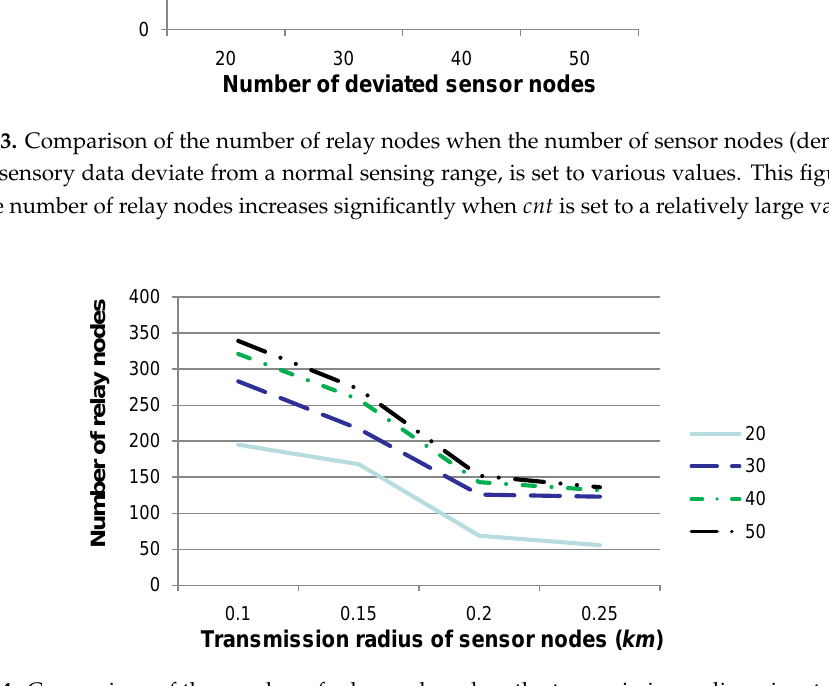
Figure 4. Comparison of the number of relay nodes when the transmission radius r is set to various values and the number of deviated sensor nodes is set to 20, 30, 40 or 50, respectively. This figure shows that the number of relay nodes is mostly impacted by the density of deviated sensor nodes, which is determined by r and the number of deviated sensor nodes in the network